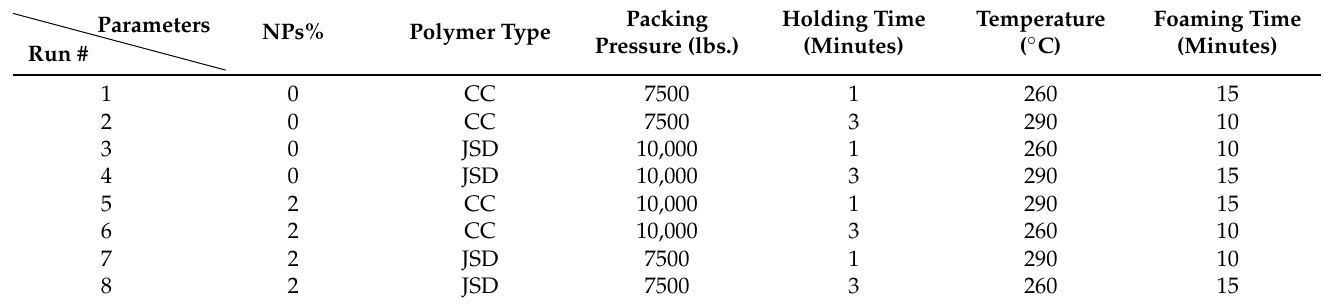
Table 1. The Taguchi Map design for this research. NPs: Nanoparticles; JAD: Jotun Super Durable 2903 ® ; CC: Corro-Coat PE Series 7 ® .